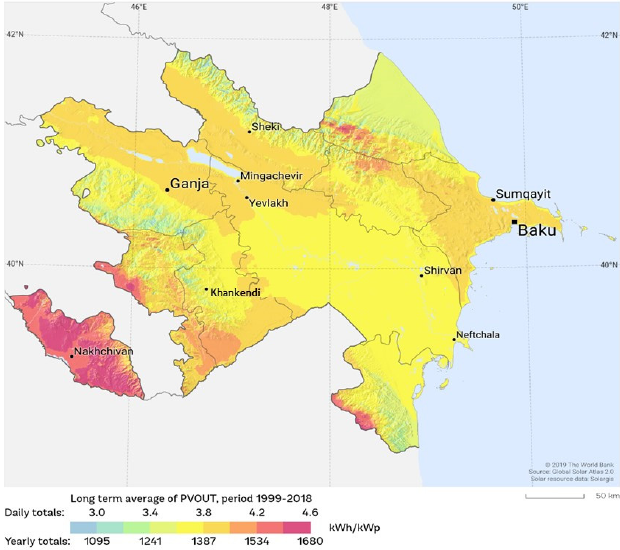
Figure 5. The photovoltaic power potential of Azerbaijan [26].